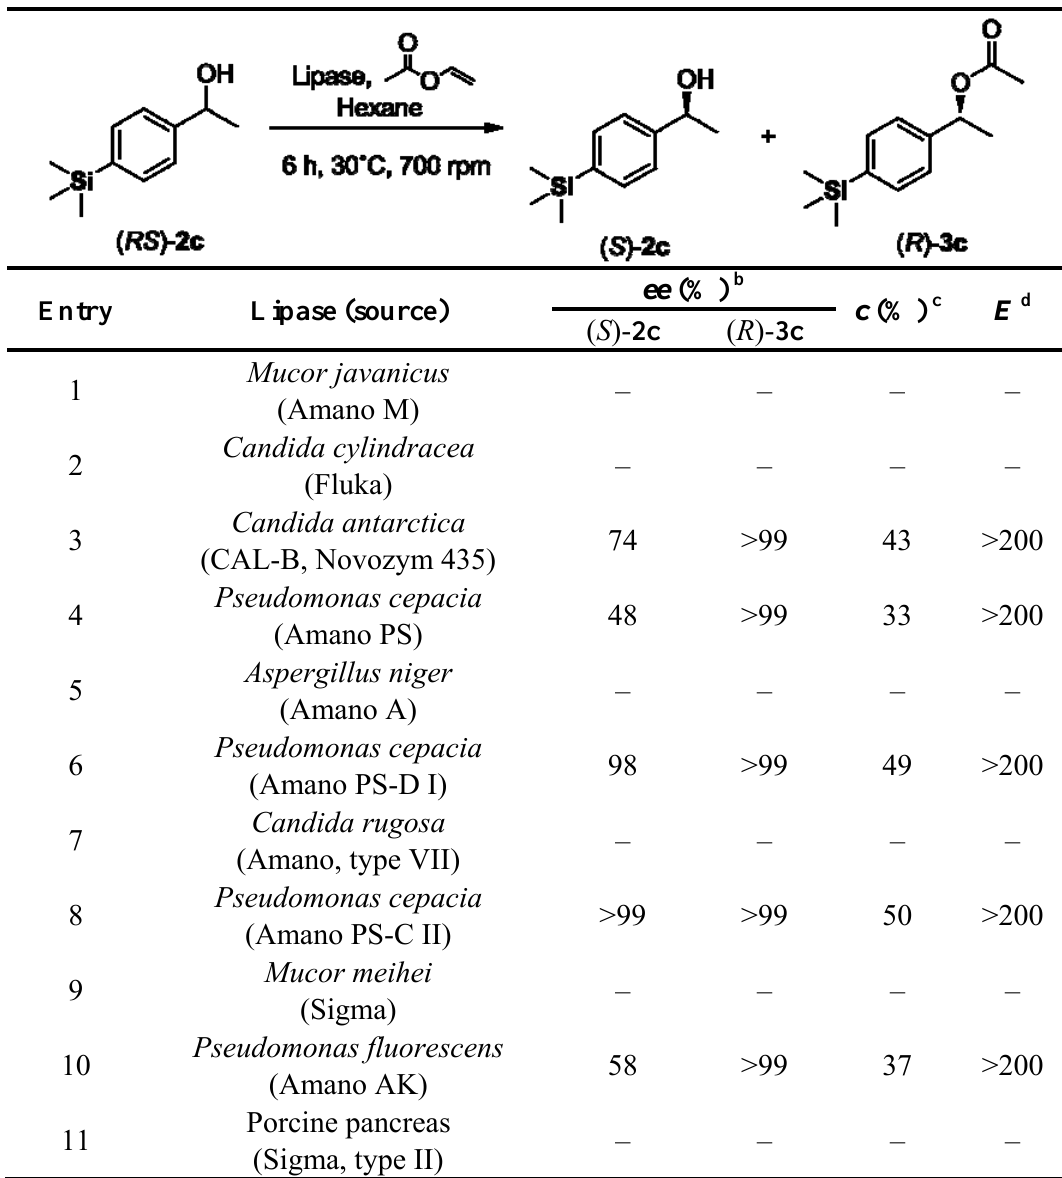
Table 1. Screening of lipases for the kinetic resolution of ( RS )- 2c a